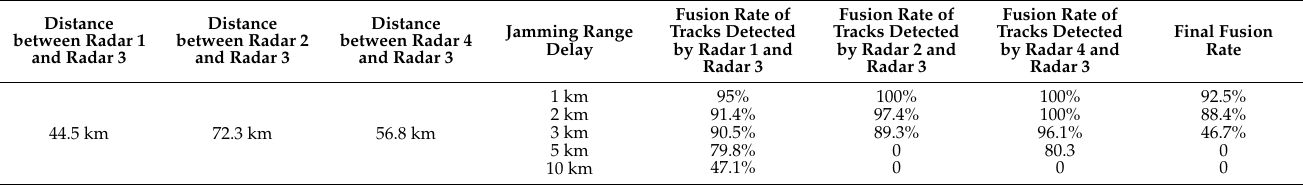
Table 8. Jamming performance evaluation results of ground ‐ based radar network (four radars).